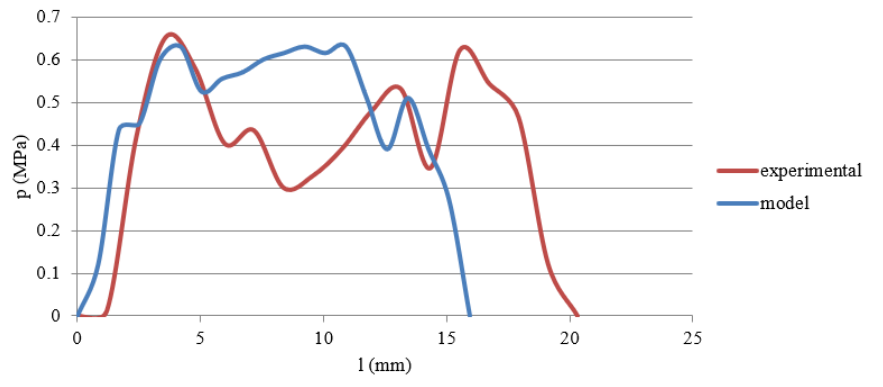
Figure 18. Surface pressure values as a function of distance for dropping an apple from a height of 30 mm on a wooden substrate.